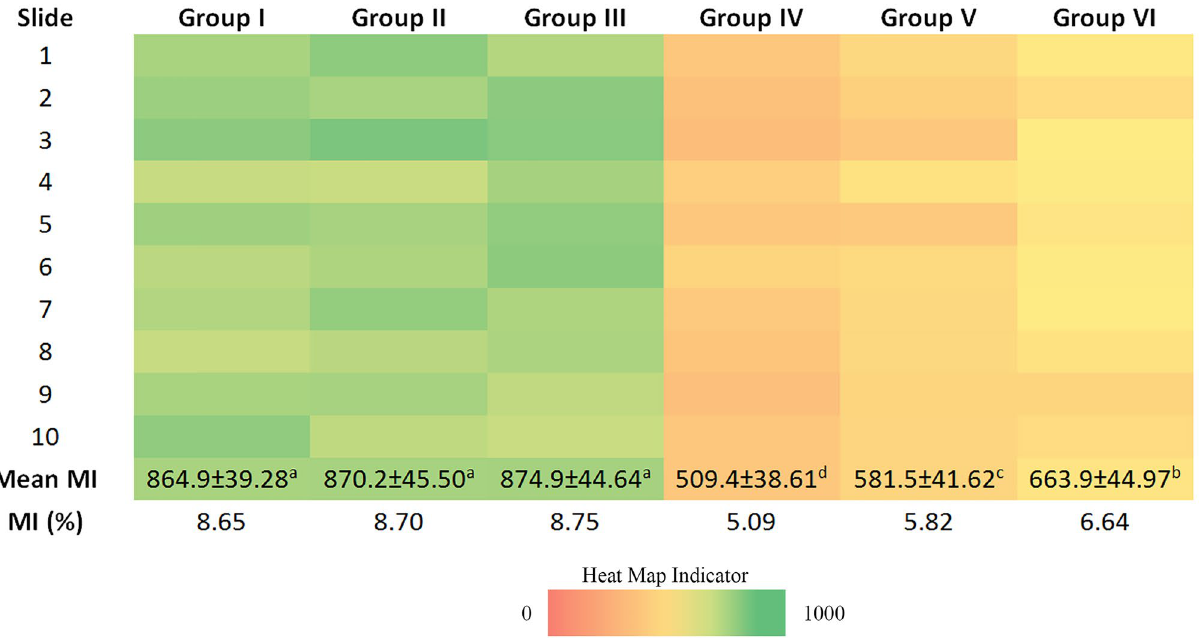
Figure 2. Effects of penoxsulam and BBE on mitotic index. [Group I: tap water (control), Group II: 25 mg/L BBE, Group III: 50 mg/L BBE, Group IV: 20 μg/L penoxsulam, Group V: 20 μg/L penoxsulam + 25 mg/L BBE,